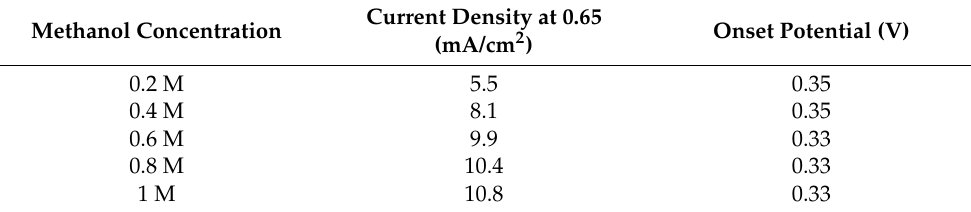
Table 4. Current density values of different Ni: Y concentration thin films at the specified potential. N:Y